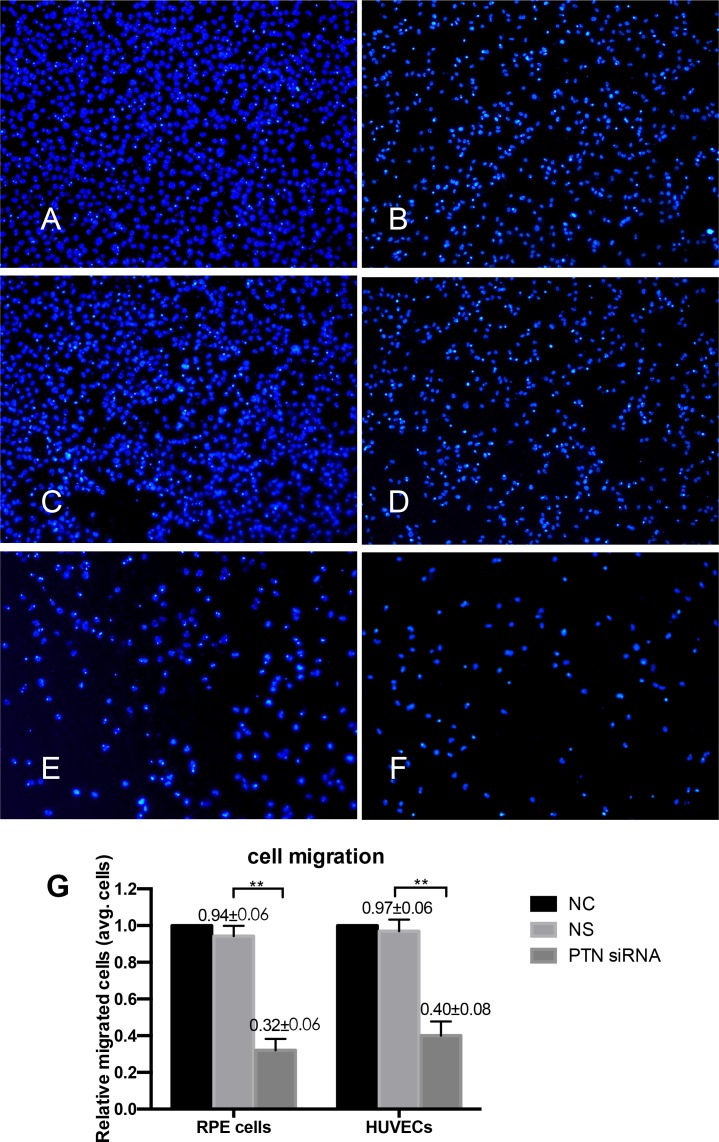
Effect of PTN on cell migration.Cell nuclei were stained with DAPI and are shown as blue dots. Cells from five random view fields were counted, and the average was used for statistical analysis. The migratory activity of PTN-siRNA-treated (E, F) groups was significantly inhibited compared to the NC (A, B) and NS (C, D) groups. Panel G shows the statistical results. The data are presented as the means ± SD. NC was set to 100%. ** P< 0.01.